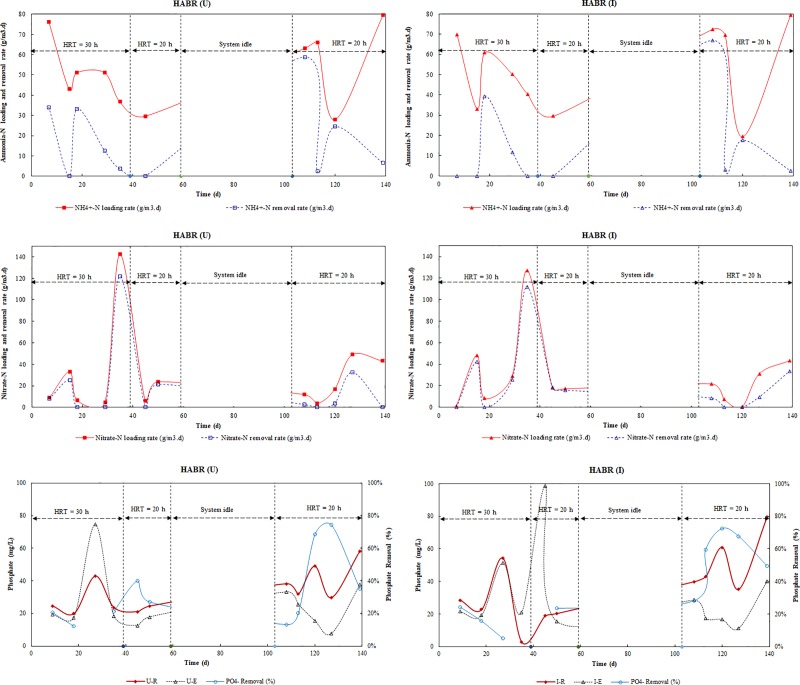
NH4+-N, NO3--N, and PO43- loading and removal rate of HABR (U) and HABR (I).